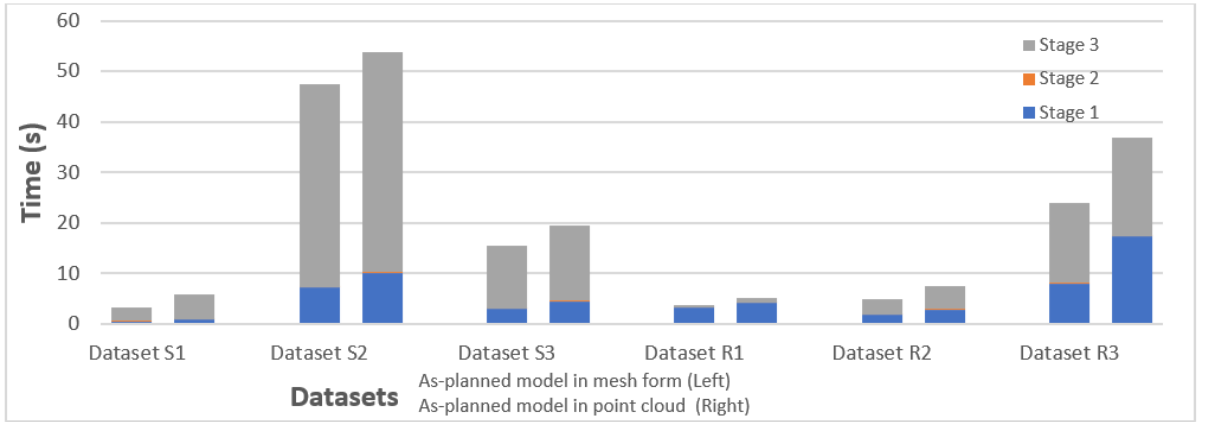
Figure 15. Comparison of computation time of the proposed technique when the as-planned model is processed in a mesh form ( left ) vs. a point cloud form ( right )